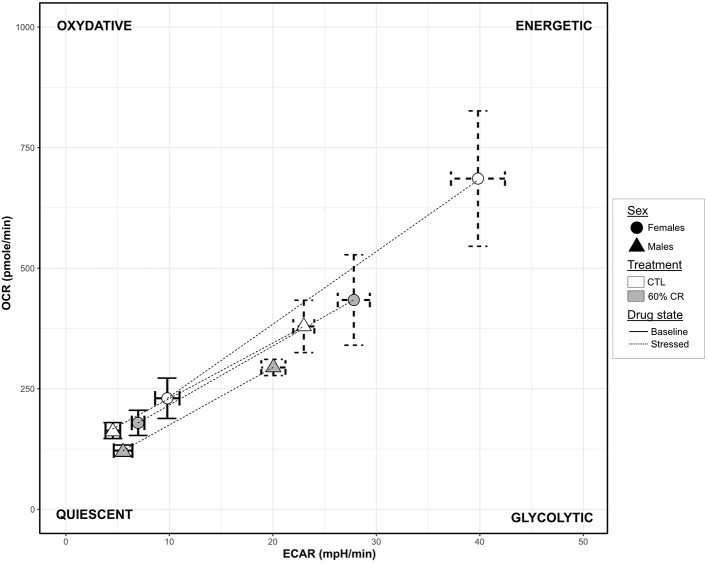
Graphic representation of the cellular metabolic potential measured in cultured fibroblasts from female (circles) and male (triangles) mouse lemurs before (CTL, white) and after (60% CR, gray) a 2-week exposure to a 60% caloric restriction. Metabolic Potentials (mean + sd) are represented by dashed lines between two cell energy phenotypes: “Basal OCR/ECAR” (sd in solid lines) and “Stressed OCR/ECAR” (sd in dashed lines; determined under FCCP conditions, chemically mimicking an induced energy demand). The 2-dimension description of the metabolic potential informs on the general capacity of the cells to meet an energy demand either by glycolysis (“Glycolytic” phenotype), oxidative respiration (“Oxydative” phenotype) or both (“Energetic” phenotype).